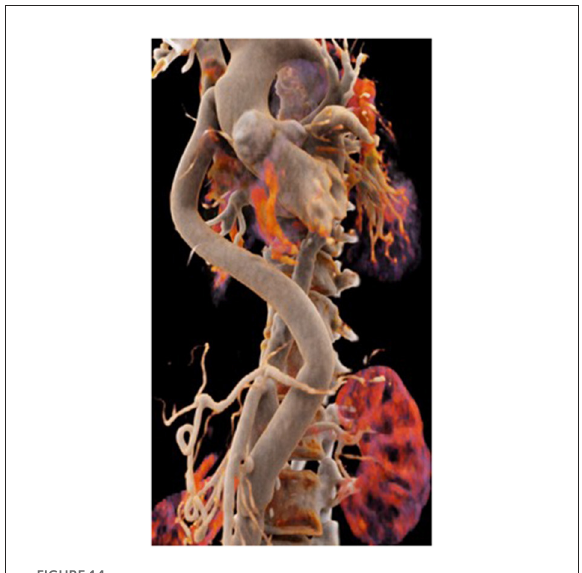
FIGURE14 Postoperative 3-D reconstruction of the CT-angio following ascending to infrarenal bypass in the patient with very calcified and narrowed descending aorta following Takayasu